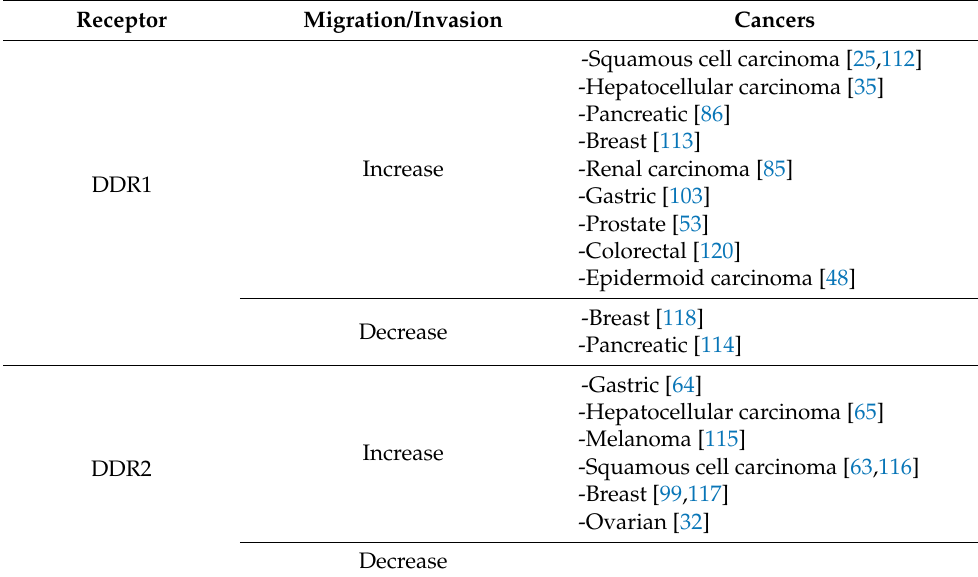
Table 4. Roles of DDRs in tumor cell migration and/or